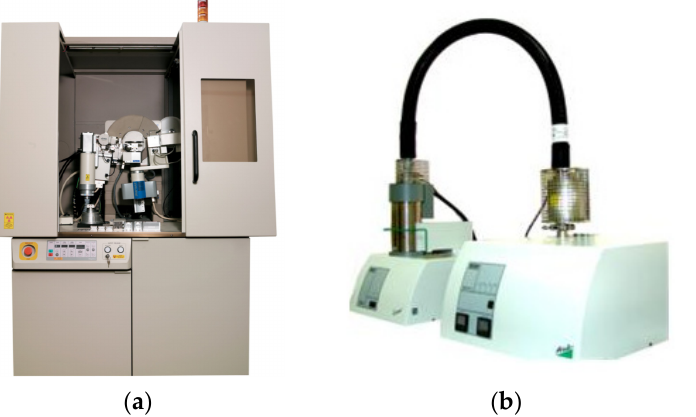
Figure 5. Photos of the chemical composition analysis equipment: ( a ) XRD equipment; and ( b ) TGA equipment.